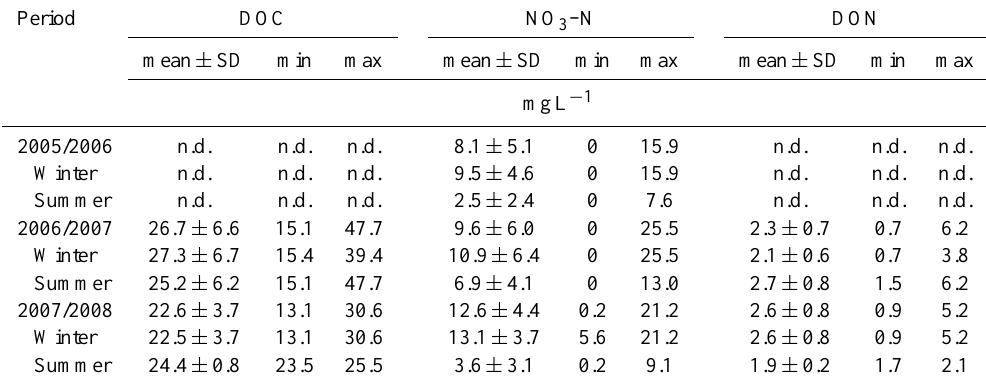
Table 4. Dissolved organic carbon (DOC), nitrate–nitrogen (NO 3 –N) and dissolved organic nitrogen (DON) concentrations in the ditch (n.d.: not